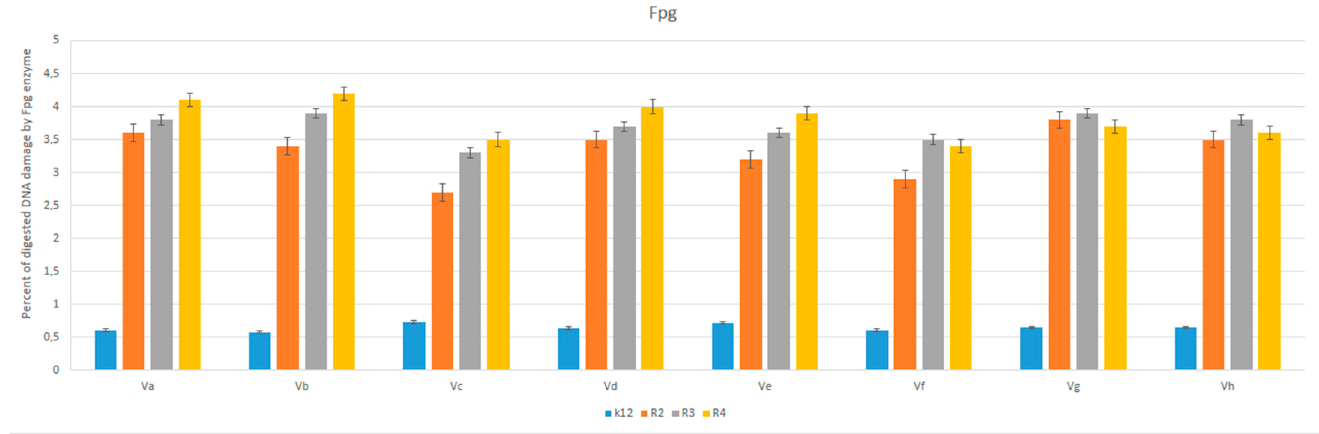
Figure 6. Percentage of plasmid DNA recognized by Fpg enzyme ( y -axis) with model bacterial, K12, and R2–R4 strains ( x -axis). All analyzed compounds numbered were statistically significant at <0.05 * (see Table 2 and Supplementary Materials Figure S2 panel A and B).